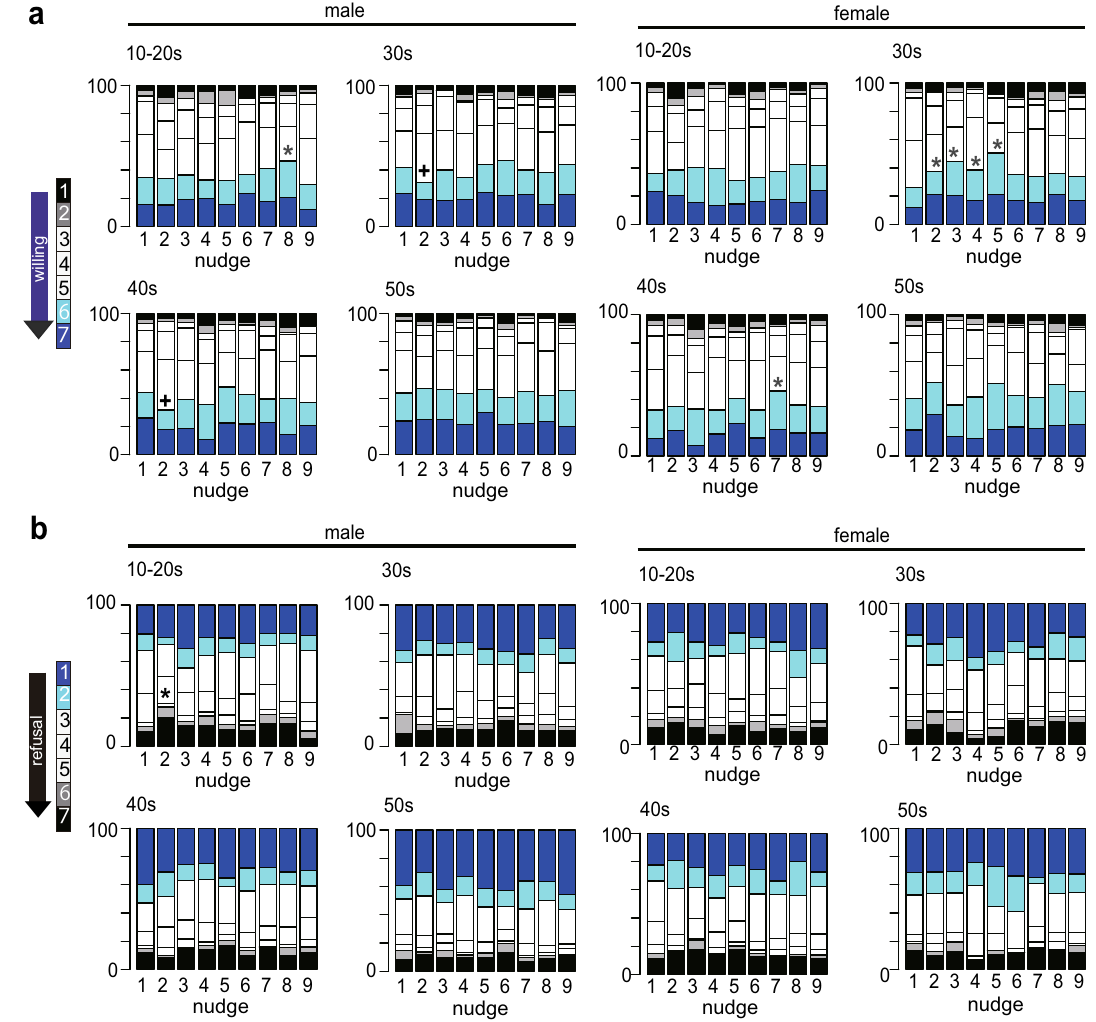
Figure 2. Effect of nudges on willingness/refusal to be vaccinated. The ratios of responses to Question A (a; willingness) and Question B (b; refusal) by age and gender are shown for each nudge. Nudges that significantly increased the willingness to be vaccinated are indicated by blue asterisks, those that decrease the willingness to be vaccinated are indicated by black crosses, and those that promoted refusal to be vaccinated are indicated by the black